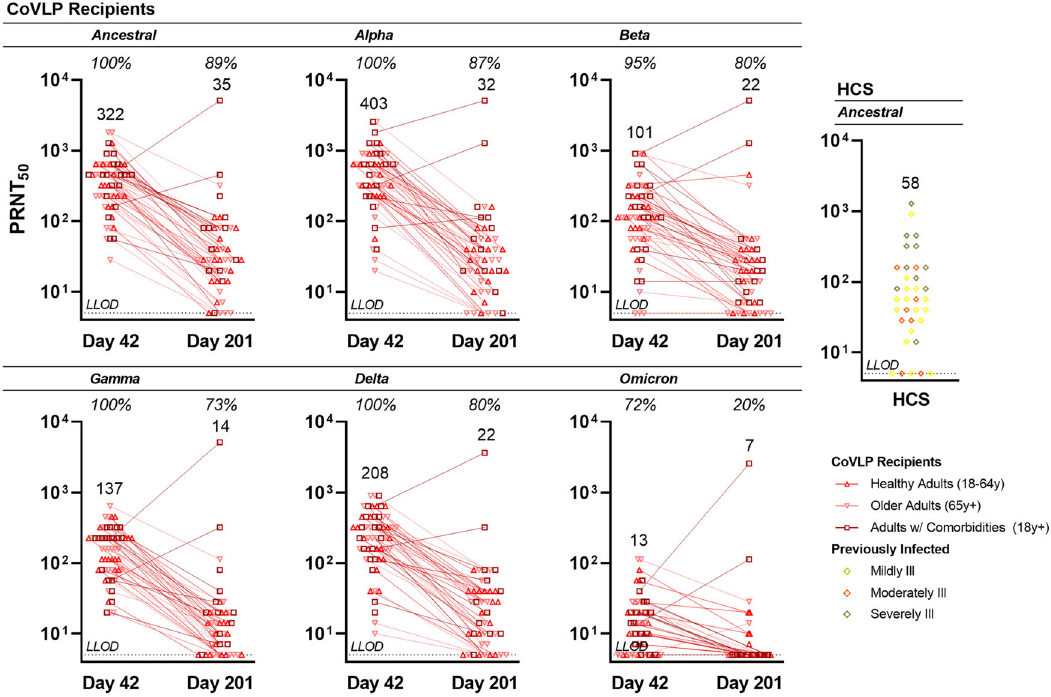
Fig. 4 Neutralizing antibody cross-reactivity to SARS-CoV-2 variants. To evaluate neutralizing antibody cross-reactivity, NAb of participants vaccinated with 3.75 µg CoVLP adjuvanted with AS03 ( n = 19, 20, and 18 for Healthy Adults aged 18 – 64, Older Adults aged 65 or more, and Adults with Comorbidities, respectively at D42 and n = 17, 15, and 13 for Healthy Adults aged 18 – 64, Older Adults aged 65 or more, and Adults with Comorbidities, respectively at D201) were quanti fi ed in a live virus neutralization assay with the ancestral strain and the Alpha, Beta, Gamma, Delta and Omicron variants. Convalescent sera or plasma samples were collected at least 14 days after a positive diagnosis of COVID- 19 (RT-PCR) from individuals whose illness was classi fi ed as mild, moderate, or severe/critical ( n = 35). Individual values are indicated with red lines; geometric means are indicated above each series of data points. Percentage seropositivity relative to the variant being tested are shown at the top of each dataset. The lower limit of detection (LLOD) is shown with a dotted black line. HCS: Human convalescent